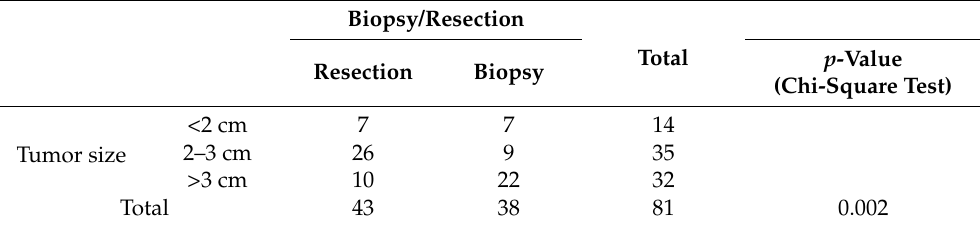
Table 1. Tumor size and biopsy/resection. Biopsy was the favored operative choice in larger tumors. Using the chi-square test, a p -value of 0.002 was measured.